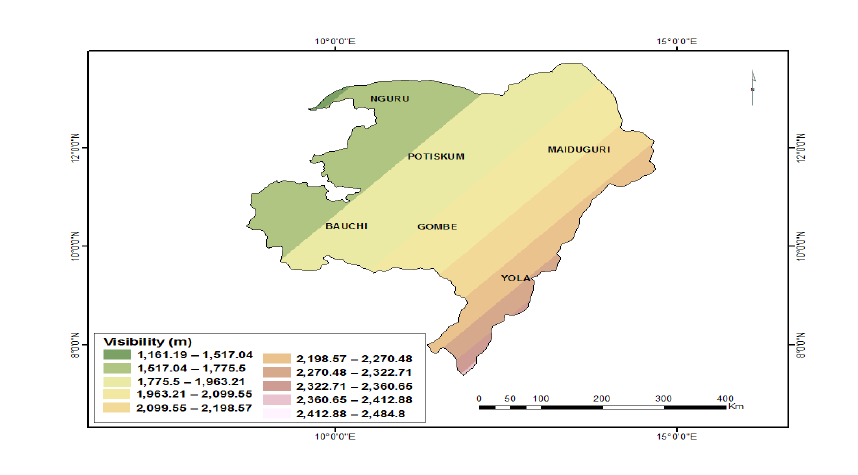
Figure 11: Spatial Air Visibility Distribution in Northeastern Nigeria (1994/1995 –